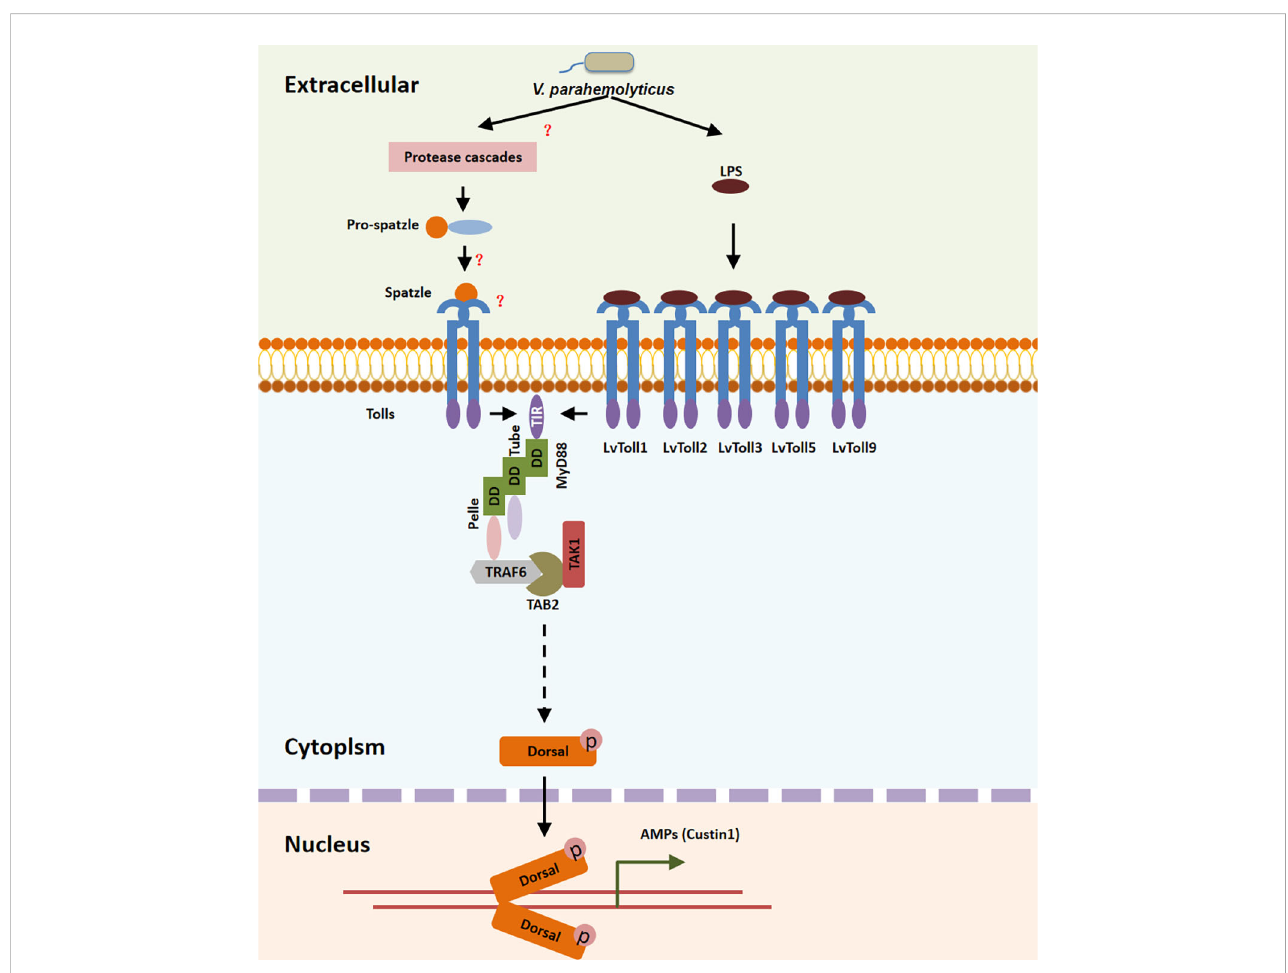
FIGURE 8 Toll/MyD88/Tube/Pelle/TRAF6-TAB2-TAK1 pathway regulates the LvDorsal-L induced anti-bacterial function. During V. parahaemolyticus infection, LPS was recognized by the extra-cellular domain of LvToll1, LvToll2, LvToll3, LvToll5 and LvToll9, the TIR of which interacted with MyD88 and induced MyD88-Tube-Pelle-TRAF6 signaling. LvTAB2 bridged TRAF6 to TAK1, allowing LvDorsal activation and LvCrustin1